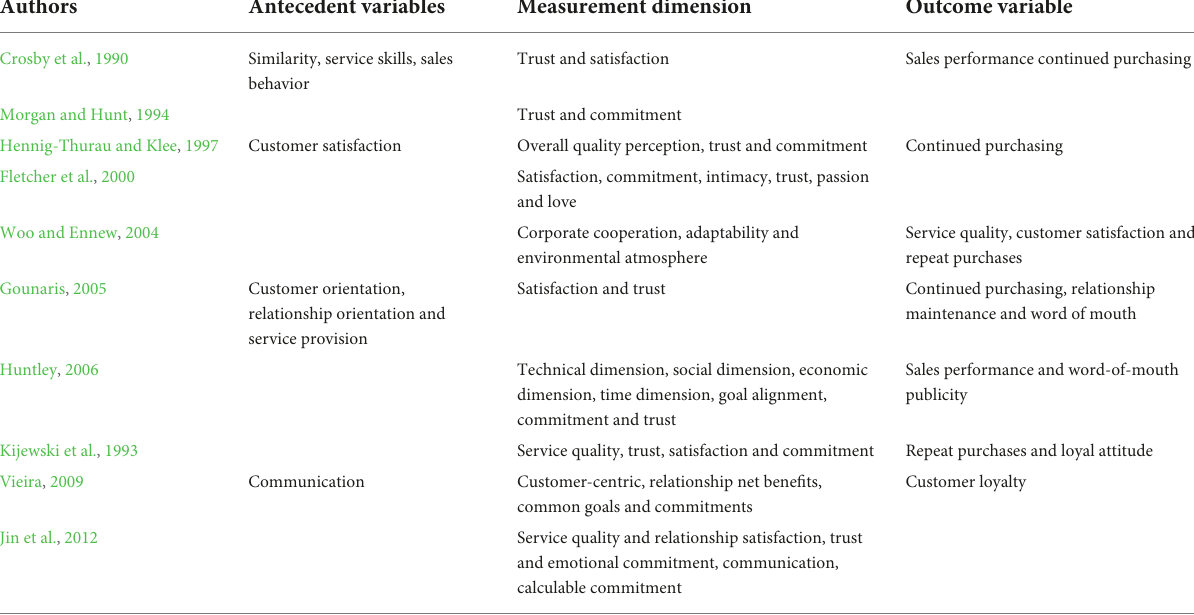
TABLE 1 List of selected representative research dimensions of relationship quality. Authors Antecedent variables Measurement dimension Outcome variable Crosby et al.,